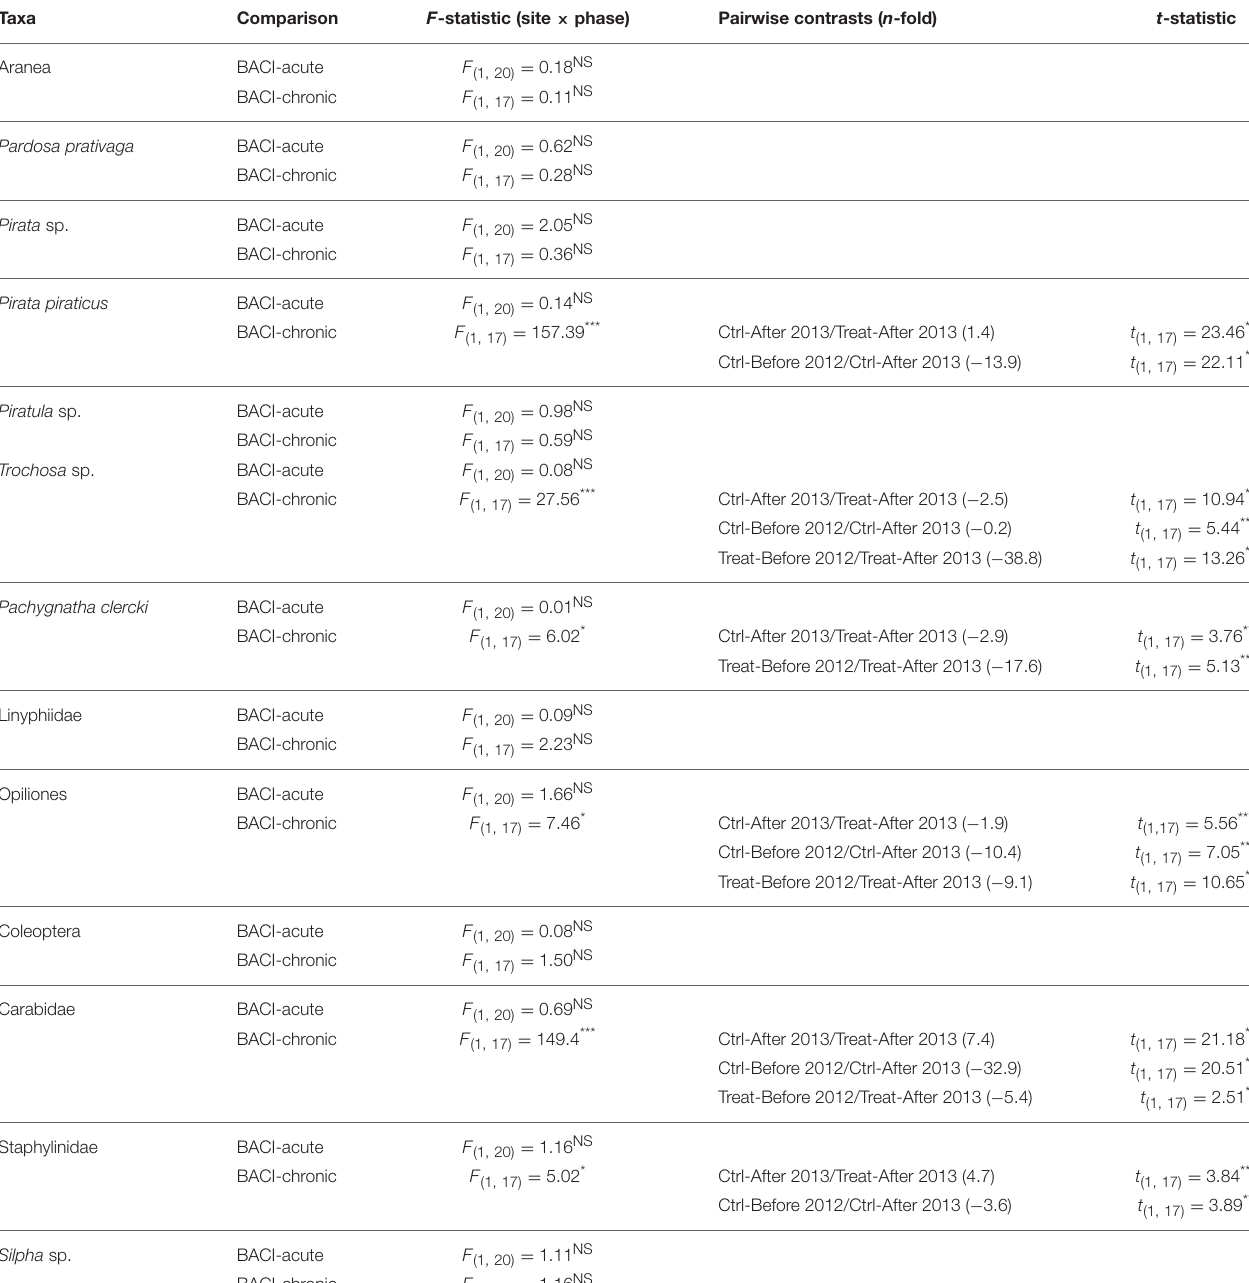
TABLE 2 | Arthropod abundance (CPUE) analysed using a BACI design for 13 taxa of ground-dwelling secondary consumers (from pitfall traps) taxonomically identified in both 2012 and 2013 samplings (see Appendix